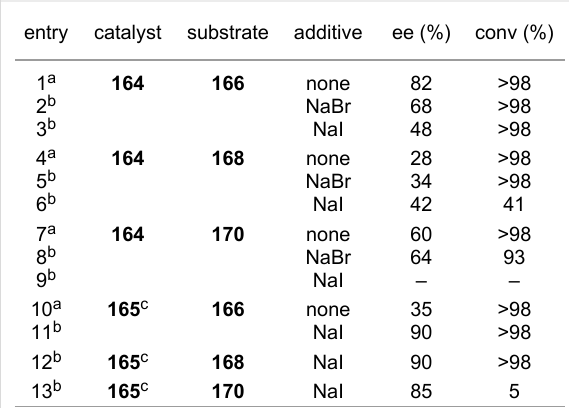
Table 6: ARCM of prochiral trienes 166 , 168 , and 170 promoted by catalysts 164 and 165 .